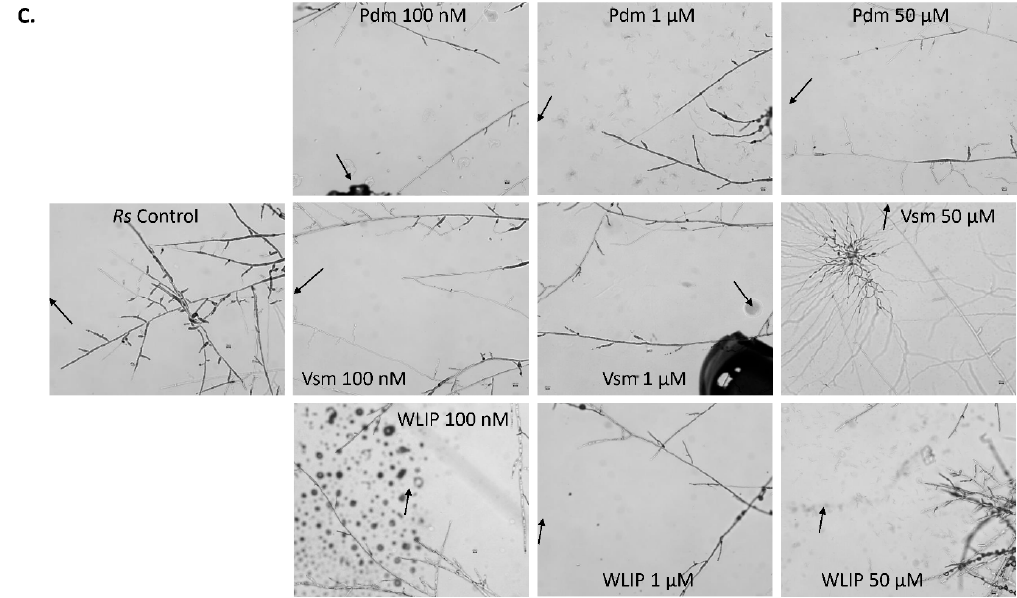
Figure 8 . In vitro bioactivity assays showing the effect of pseudodesmin, viscosinamide and WLIP on the mycelial growth and hyphal morphology of R. solani AG 2-2. ( A ) Effect of various CLP treatments and concentrations on the growth of R. solani AG 2-2. For each CLP, concentrations of 100 nm, 1 µM, 10 µM, 25 µM and 50 µM were tested. Representative images are shown. ( B ) Percentage inhibition of R. solani AG 2-2 in response to various CLP treatments and concentrations. Values indicate percentage growth inhibition relative to the control ( n = 5). The data were analyzed using Tukey’s post-hoc tests via SPSS statistics 25. Bars with different letters indicate significant differences ( p < 0.05) between treatments; vertical lines indicate the standard error (SE). The letters a/b, a’ and a’’/b’’ were used to denote statistics within treatments for pseudodesmin, viscosinamide and WLIP respectively. ( C ) Microscopic assays showing the effect of various CLP treatments and concentrations on the mycelia of R. solani AG2-2. Arrows indicate the position of the CLP droplets.